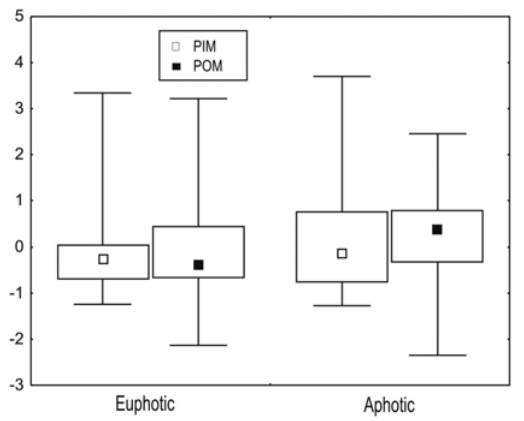
Fig. 4 – Autoscaled value distributions for nitrite, nitrate, ammonia and phosphate.